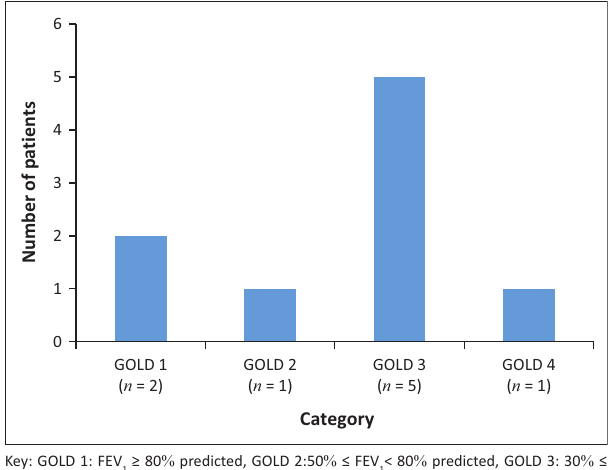
FIGURE 4: Categorisation of obstructive pattern according to GOLD criteria.